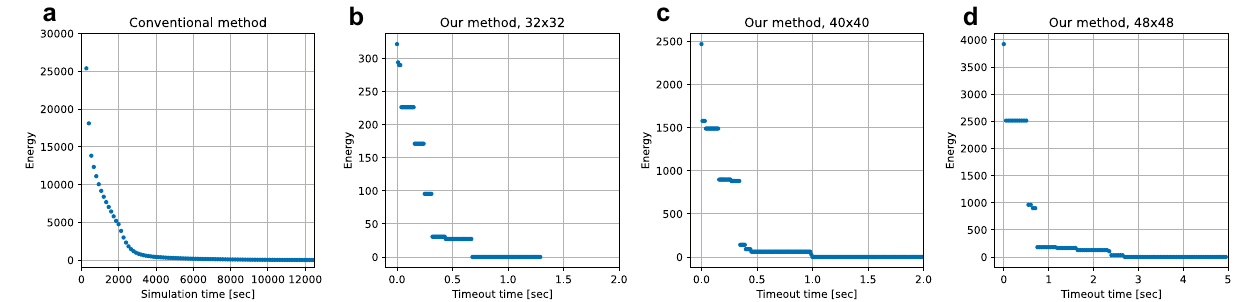
Figure 5. Energy during iterations of the conventional phase-field method and Ising machines. ( a ) Time evolution of the free energy in one simulation using the conventional method. ( b–d ) Minimum energy found in less than a specified time with different grid sizes.